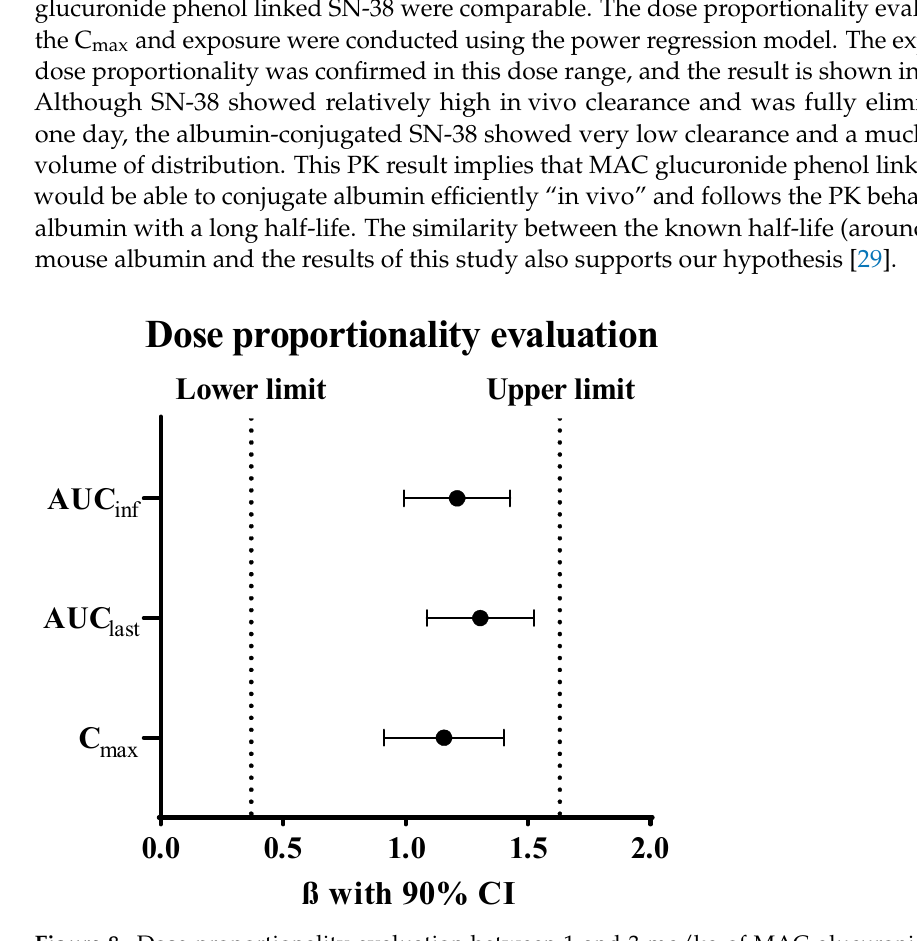
Figure 8. Dose proportionality evaluation between 1 and 3 mg/kg of MAC glucuronide phenol linked SN-38 using the power regression model.